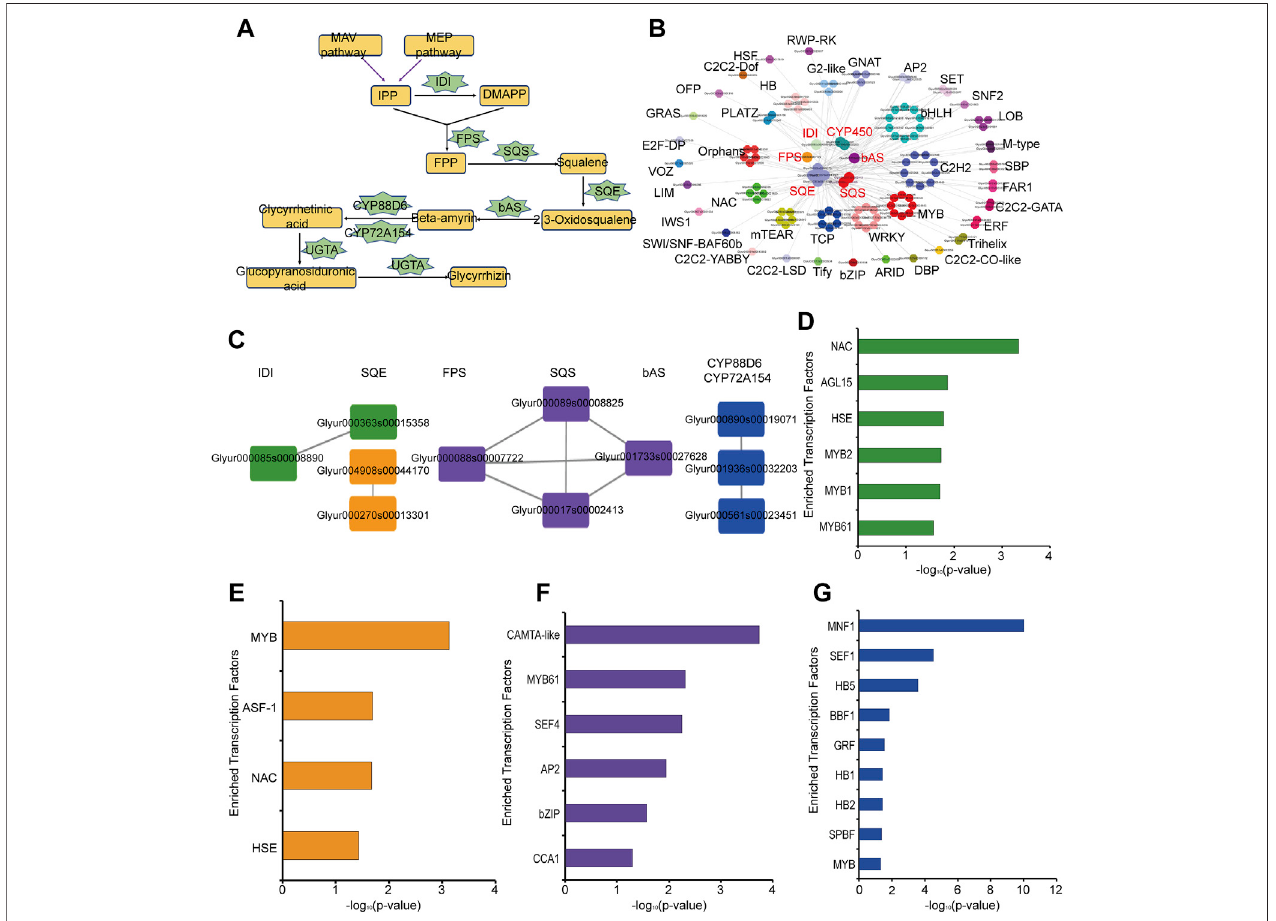
FIGURE3| Analysisofkeyenzymesinglycyrrhizinbiosynthesispathwayin Glycyrrhiza uralensisFisch. (A) glycyrrhizin biosynthesispathway andkeyenzymes. (B) Co-expression relationship between transcription factors (TFs) and key enzymes in glycyrrhizin biosynthesis. (C) The analysis results of the co-expression relationship between key enzymes, which can be divided into 4 groups, the fi rst subgroup is the co-expression relationship between 1 IDI and 1 SQE (green, #389339), the second subgroup represents co-expression relationship between 2 SQE (orange, #f3951b), the third subgroup represents the co-expression relationship of 1FPS, 2 SQS and 1bAS (purple, #674b9c),the fourth subgroup represents co-expression relationship in3 CYP450 genes (blue, #204fa2). (D) Motif enrichment analysis results ofthe fi rstgroup(green,#389339). (E) Motifenrichmentanalysisresultsofthesecondgroup(orange,#f3951b). (F) Motifenrichmentanalysisresults ofthethirdgroup(purple, #674b9c). (G) Motif enrichment analysis results of the fourth group (blue,